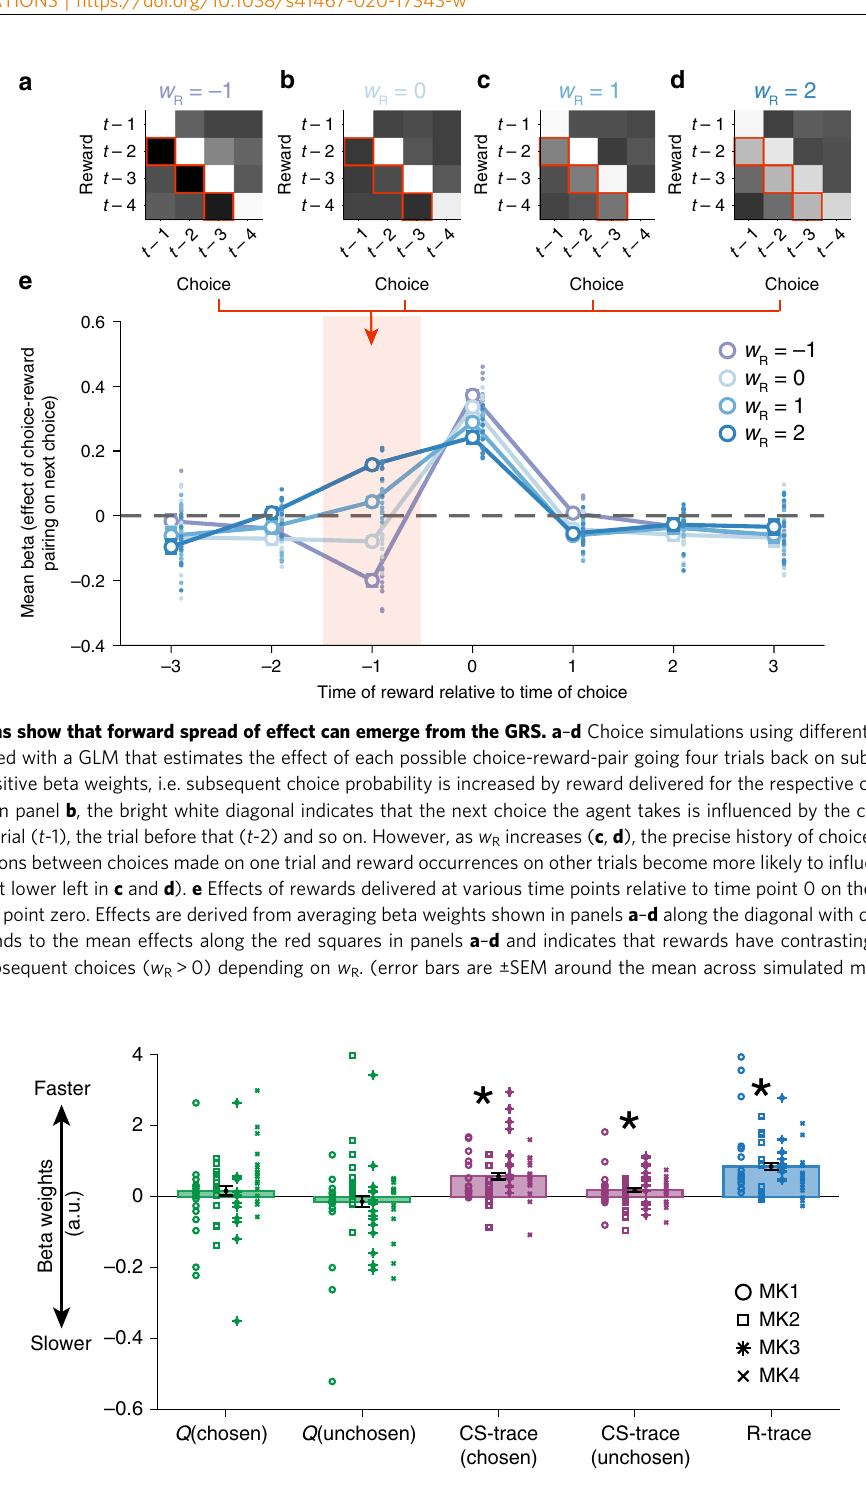
Fig. 5 GRS impacts task engagement as measured by reaction times. Beta weights of linear regression with the negative log of reaction times suggest that animals respond quicker when the choices that are offered on the current trial were recently pursued and also when R-trace is high (asterisks indicate p < 0.001, except for CS-trace (unchosen) where p = 0.003; we used two-sided one-sample t -tests against zero that remain signi fi cant also after Bonferroni correction for fi ve comparisons). (error bars indicate ±SEM around the mean across sessions with n = 65). Source data are provided as Source Data fi le. Symbols indicate monkey identity; MK abbreviates